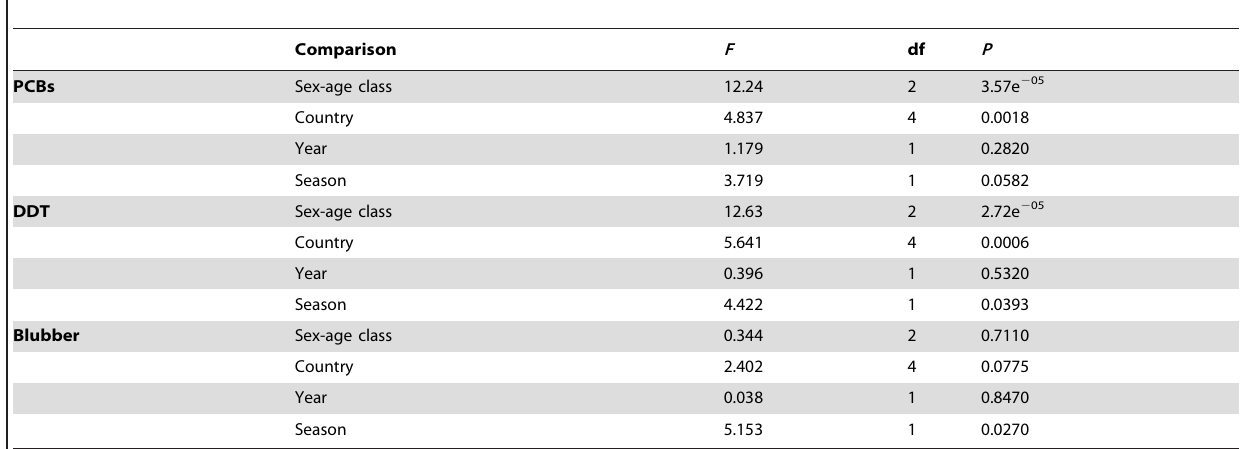
Table 2. Anova comparison for log10(PCBs), log10(DDTs) and log10(Blubber + 1) versus, Sex-age class, Country, Year and Season.